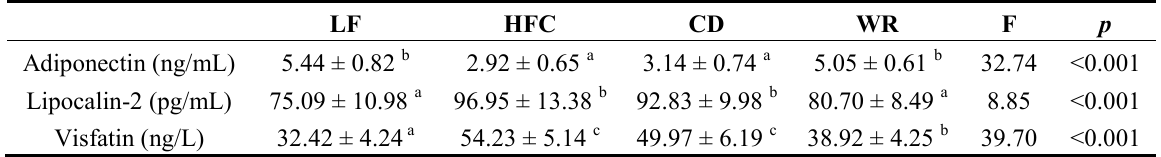
Table 3. Serum adiponectin, lipocalin-2 and visfatin concentrations, according to the four diet